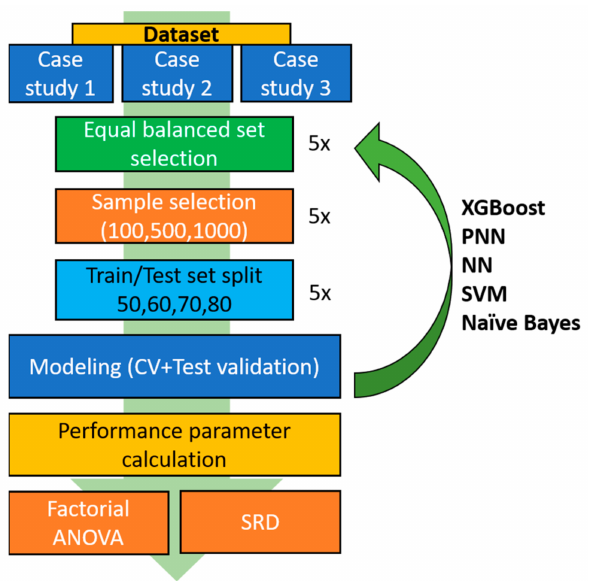
Figure 11. Workflow of the modeling process: for each case study, balanced set selection was performed in five repetitions (to account for all available molecules during modeling). Sample selection was then carried out in five repetitions for three samples sizes, and train/test splitting was performed in five repetitions for four split ratios, resulting in altogether 125 models for each combination of settings. Then, 25 performance parameters were calculated for each model (both for cross-validation and test validation), which were used to compare the models with factorial ANOVA and sum of ranking differences